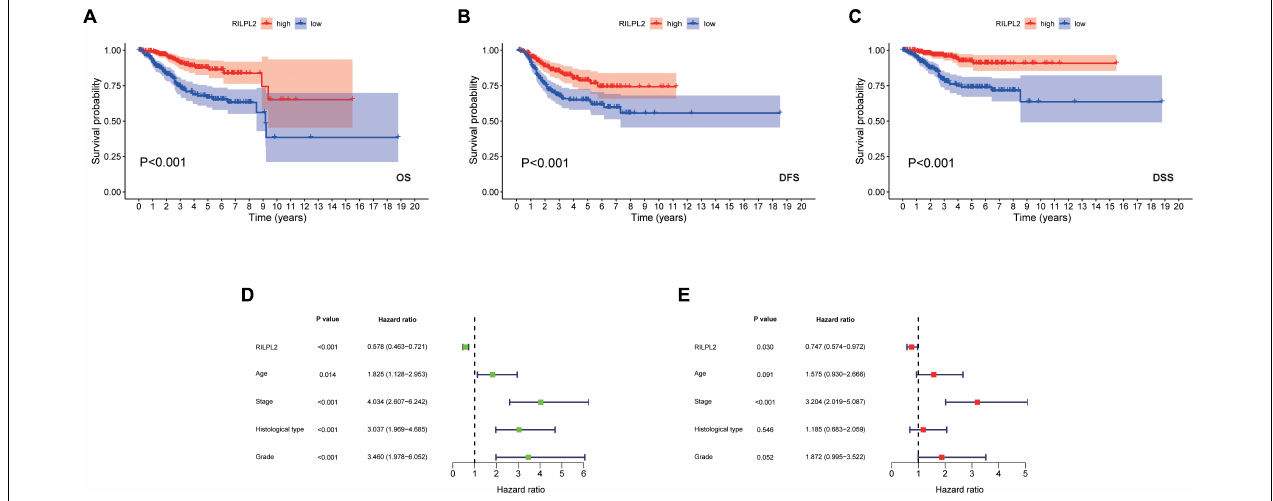
Frontiers in Molecular Biosciences |